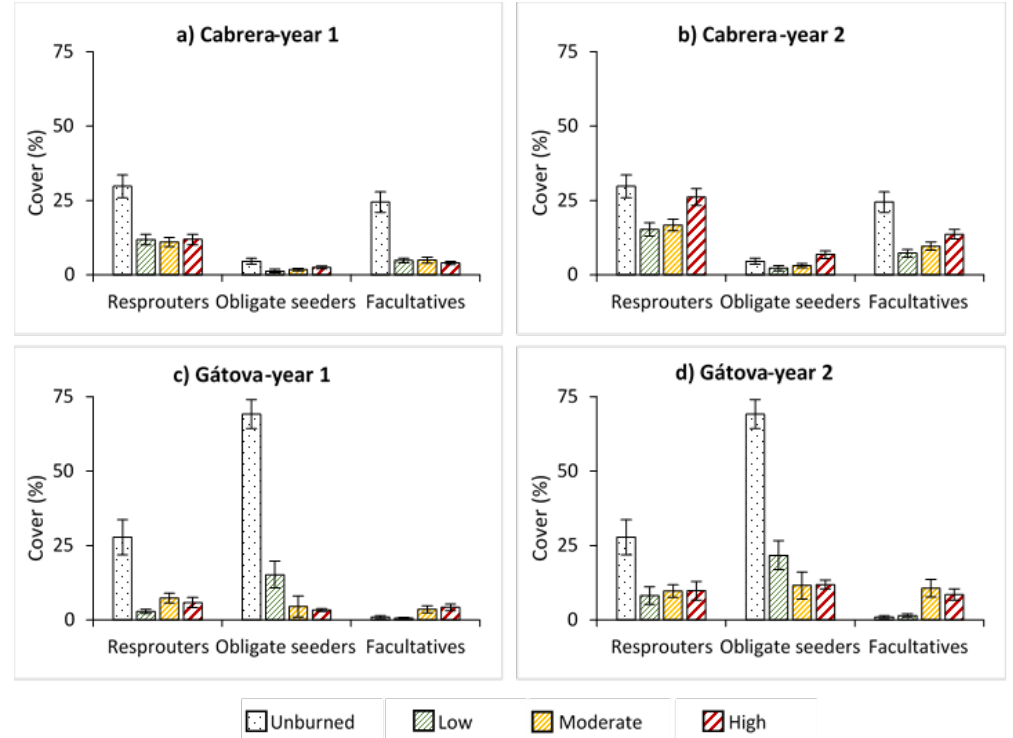
Figure 4. Average cover (%) of resprouter, obligate seeder, and facultative species, and standard error for each burn severity level (unburned, low, moderate, and high) measured by the composite burn index (CBI) in: ( a ) Cabrera, one year post-fire; ( b ) Cabrera, two years post-fire; ( c ) Gátova, one year post-fire; and ( d ) Gátova, two years post-fire. Statistical information is provided in Tables S3 and S4 (Supplementary Material).